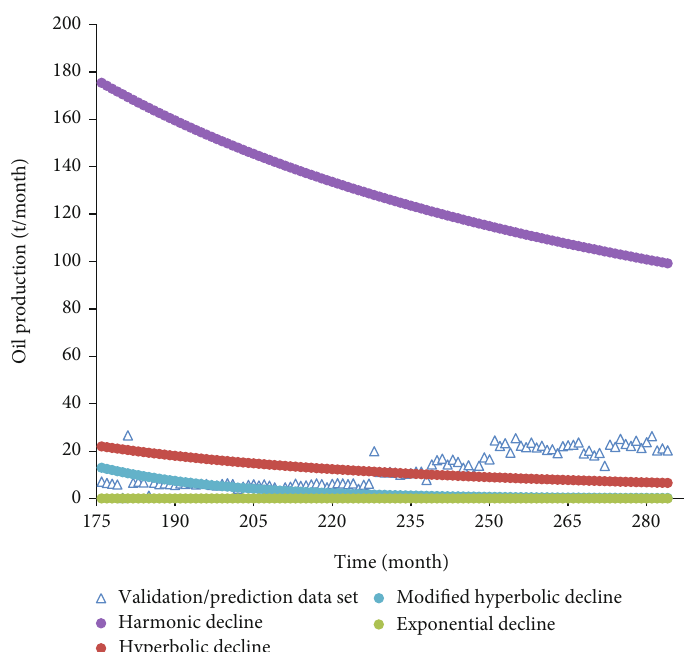
Figure 6: Comparison of prediction results of the Arps decline model and veri fi cation/prediction data set.